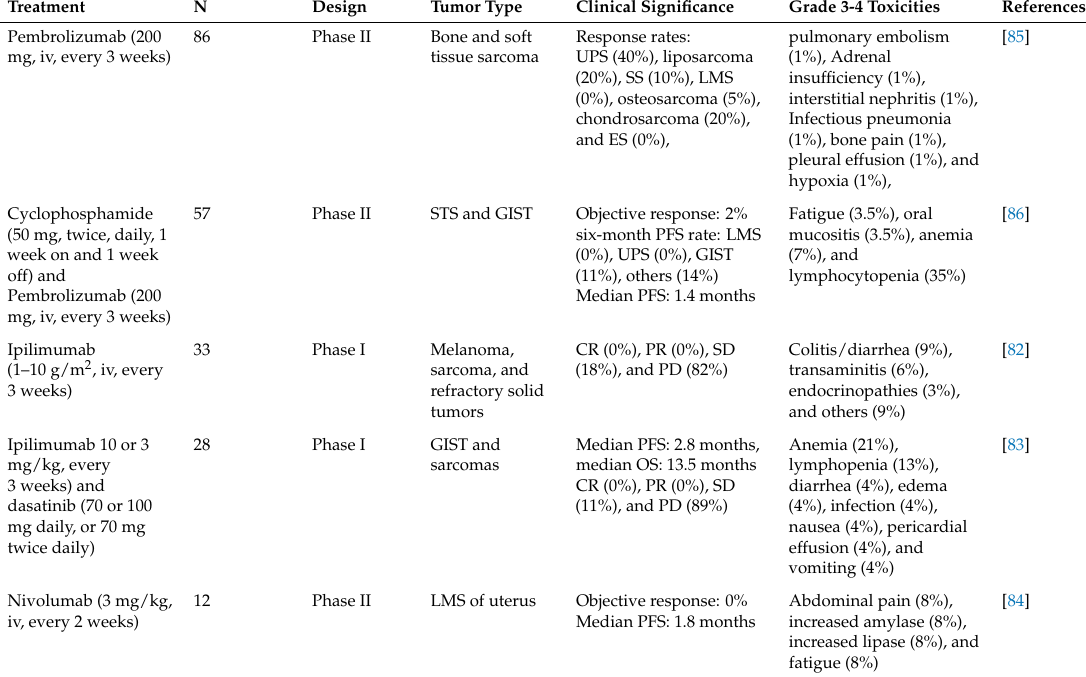
Table 2. Clinical studies of immune checkpoint